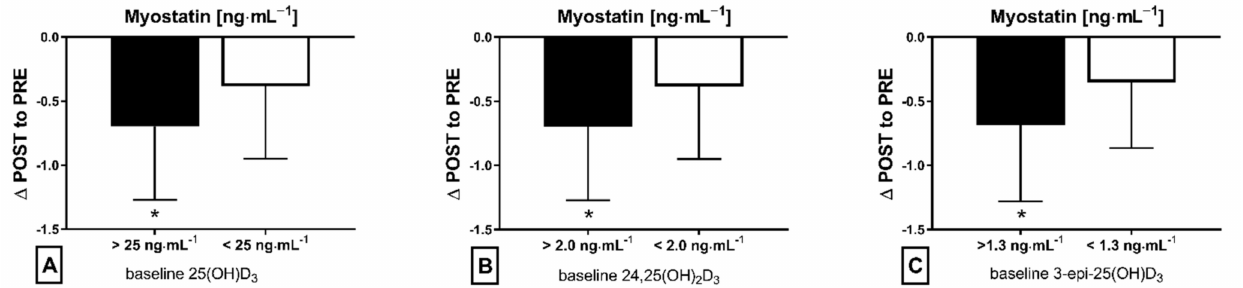
Figure 2. Myostatin concentration delta changes ( ∆ POST to PRE) dependant on baseline level of metabolite vitamin D in NW training group: ( A ) baseline 25(OH)D 3 , ( B ) baseline 24,25(OH) 2 D 3 and ( C ) baseline 3-epi-25(OH)D 3 ; * statistically significant result (post hoc tests)— p <